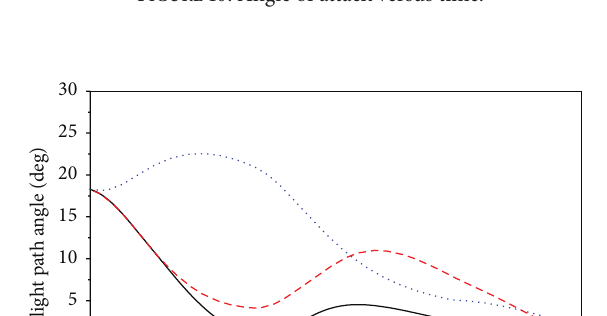
Figure 10: Angle of attack versus time.